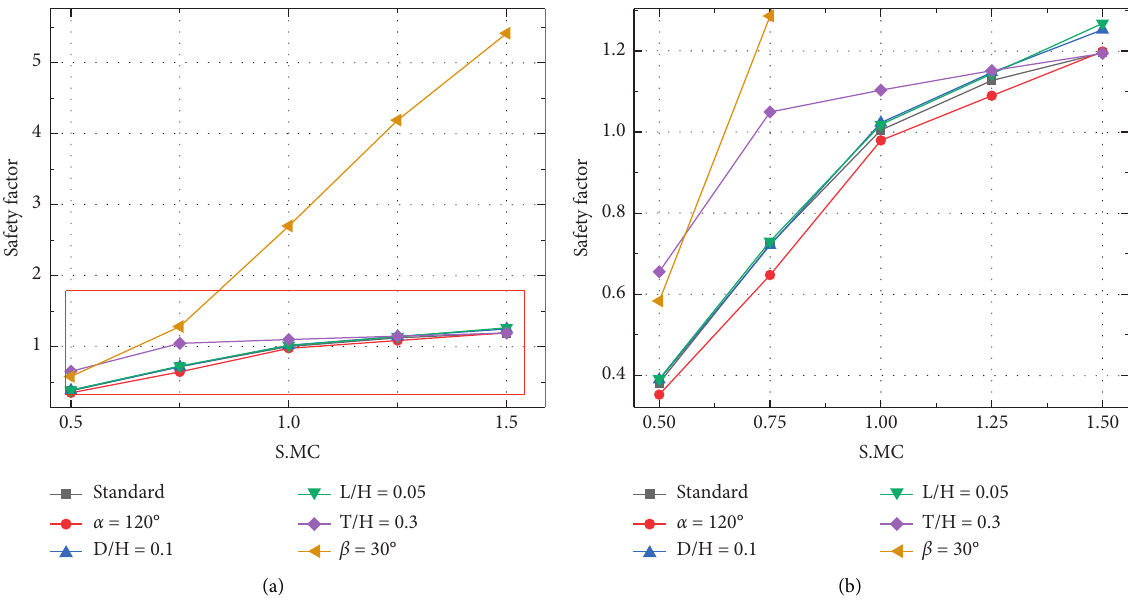
Figure 5: The influence of top layer strength on slope stability. (a) Calculation results. (b) Partial calculation results.